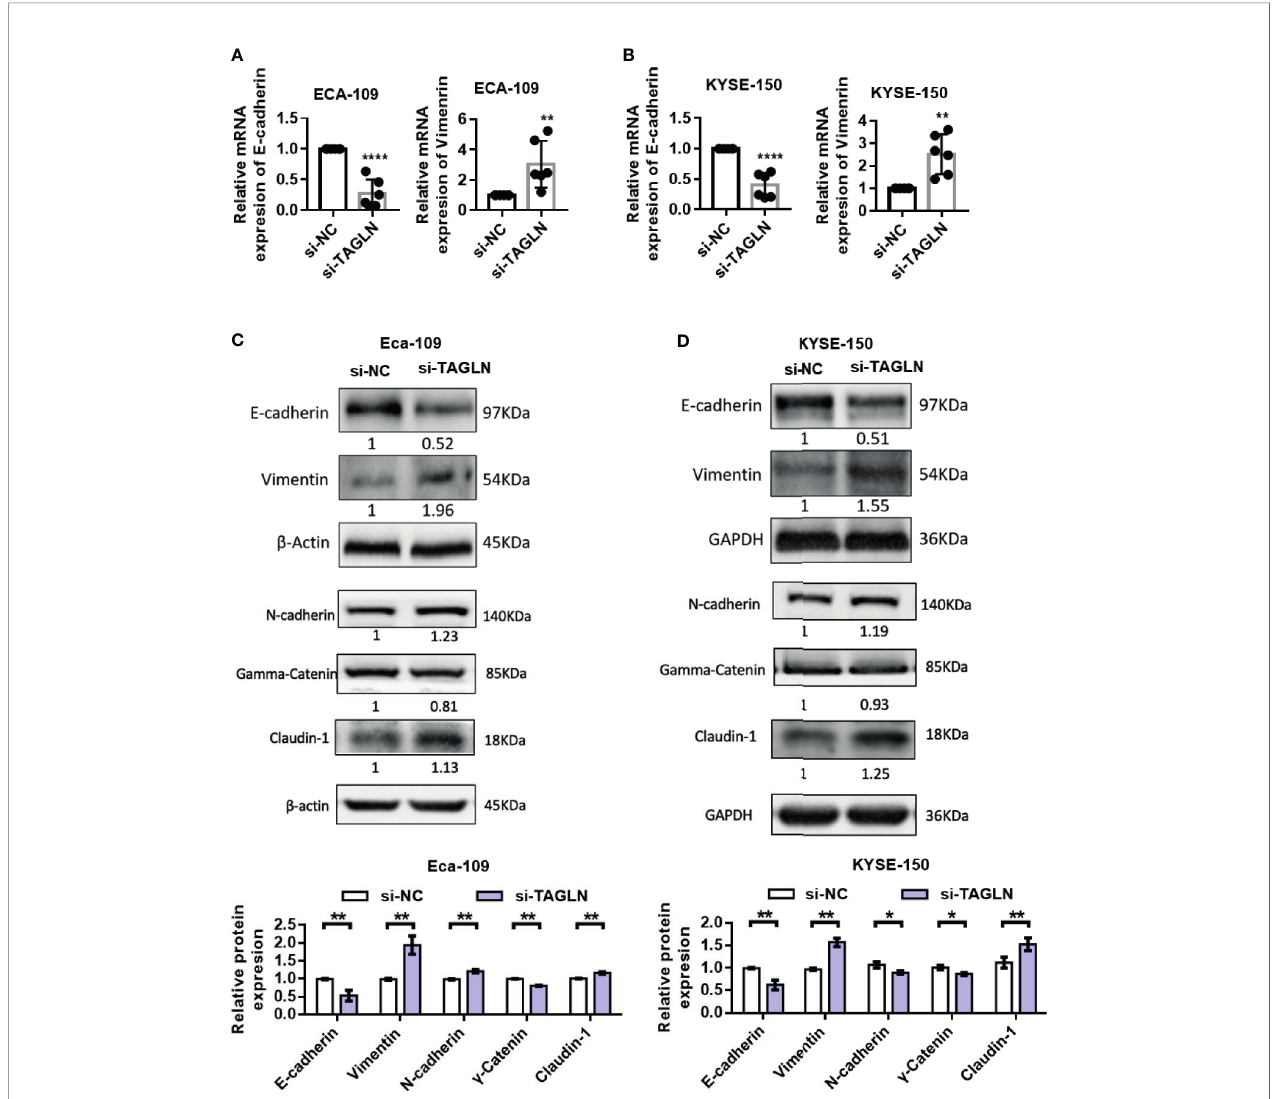
FIGURE 5 | Effects of knockdown of Transgelin on E-cadherin and Vimentin expression in Eca-109 and KYSE-150 cells. (A) The expression levels of E-cadherin and Vimentin in Eca-109 cells after knockdown of Transgelin were detected by qRT-PCR. (B) The expression levels of E-cadherin and Vimentin in KYSE-150 cells after knockdown of Transgelin were detected by qRT-PCR. (C) The expression levels of E-cadherin, Claudin-1, N-cadherin, g -Catenin and Vimentin in Eca-109 cells after knockdown of Transgelin were detected by western blot. (D) The expression levels of E-cadherin, Claudin-1, N-cadherin, g -Catenin and Vimentin in KYSE-150 cells after knockdown of Transgelin were detected by western blot. The data are presented as the mean ± SEM of three independent experiments. * P < 0.05, ** P < 0.01, and **** P < 0.0001 by two-tailed Student ’ s